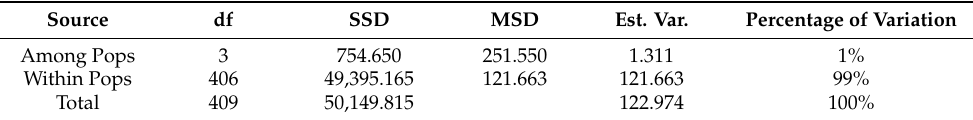
Table 7. Analysis of genetic differentiation among faba bean accessions based on the structure population analysis using